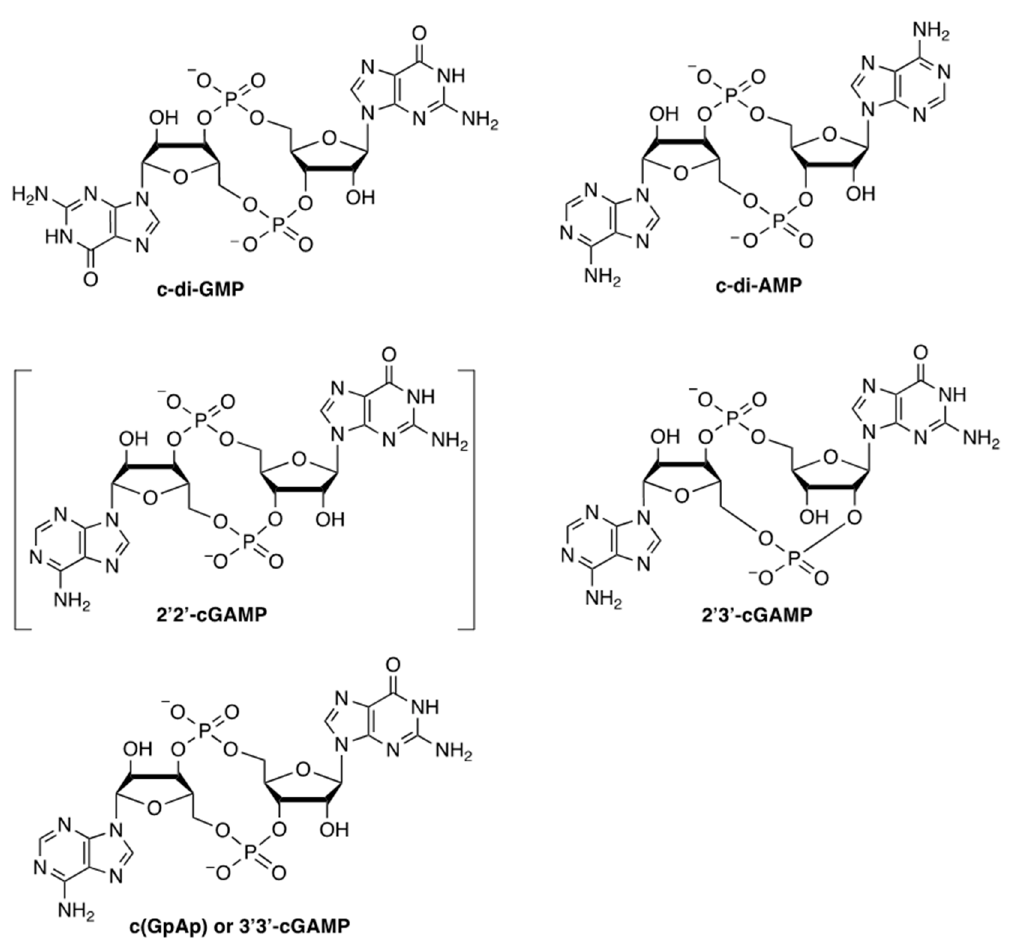
Figure 1. Chemical structures of naturally occurring cyclic dinucleotides known to date. The structure of 2 ′ 3 ′ -cGAMP was originally misassigned as 2 ′ 2 ′ -cGAMP shown in brackets.